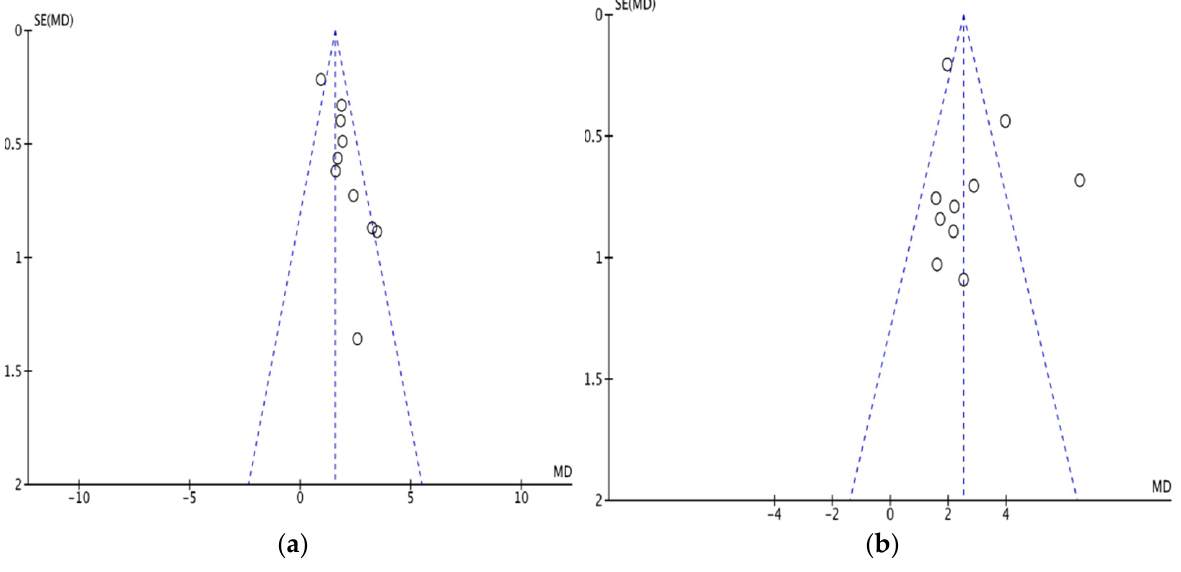
Figure 11. ( a ) MMSE bias funnel plot. ( b ) MoCA bias funnel plot.